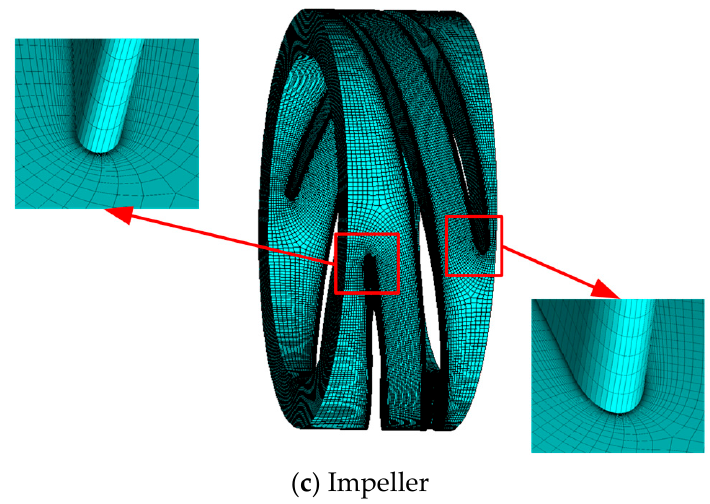
Figure 2. The mesh division of computational domains.